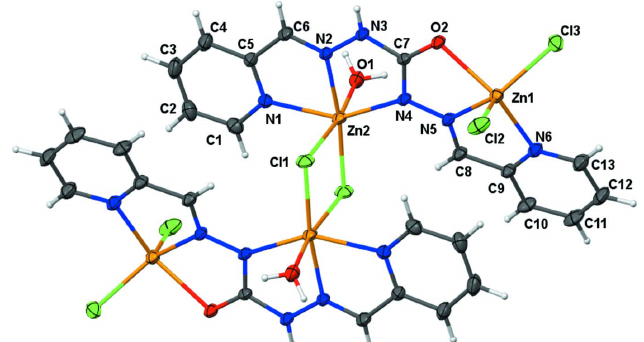
Figure 1 A view of the title compound, showing the atom-numbering scheme. Displacement ellipsoids are plotted at the 30% probability level. Unlabelled atoms are generated by the symmetry operation 1 (cid:5) x , 1 (cid:5) y , (cid:5) z